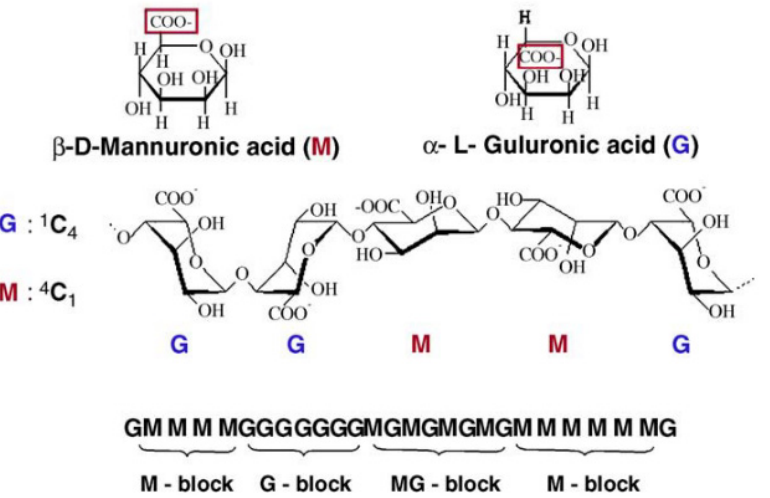
Figure 4. The structure of linear block co-polymer alginate comprising β -D-mannuronic (M) and α -L-guluronic acids (G). Reprinted with permission from ref. [64]. Copyright 2006 Elsevier.